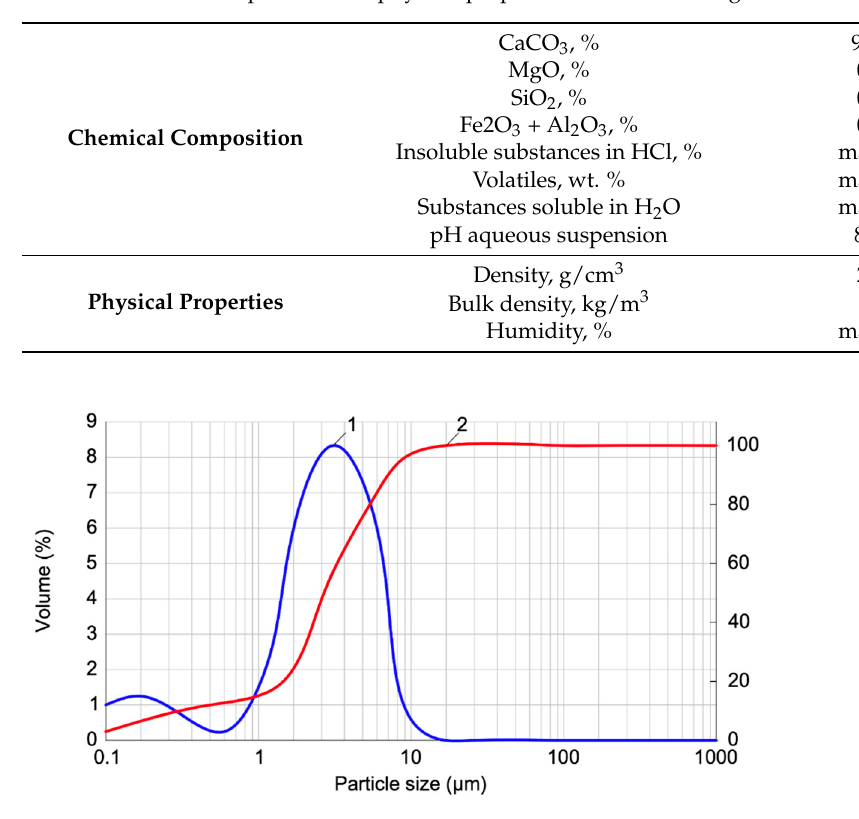
Figure 3. Curve of distribution of Km-2 grade micro calcite particles by size: 1—curve of the partial distribution of particles of a certain size (particle size) in percentage (along the left ordinate); 2—curve of the total distribution of particles as a percentage (on the right axis of ordinates).